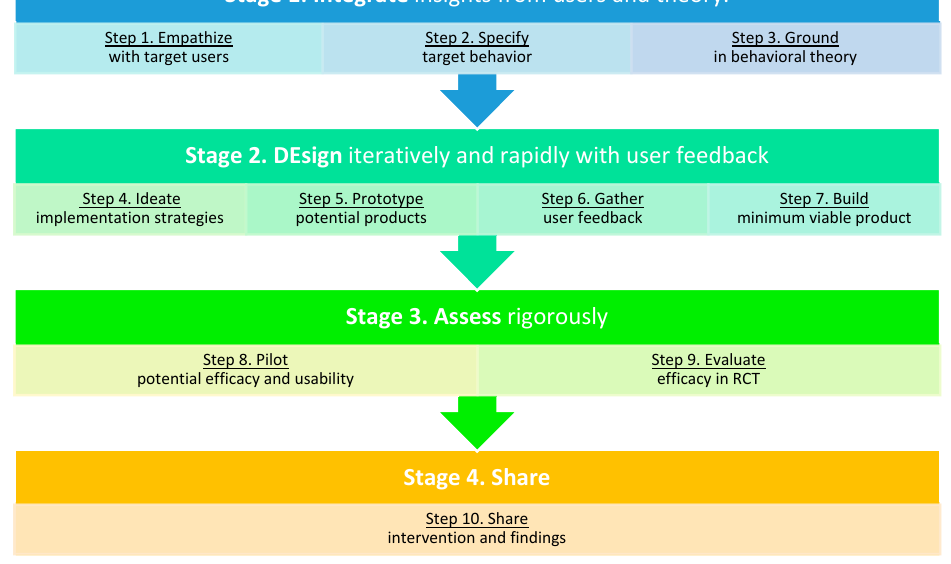
Figure 1. Adapted from IDEAS ( Integrate , DEsign , Assess , and Share ) framework by Mummah et al. [13].